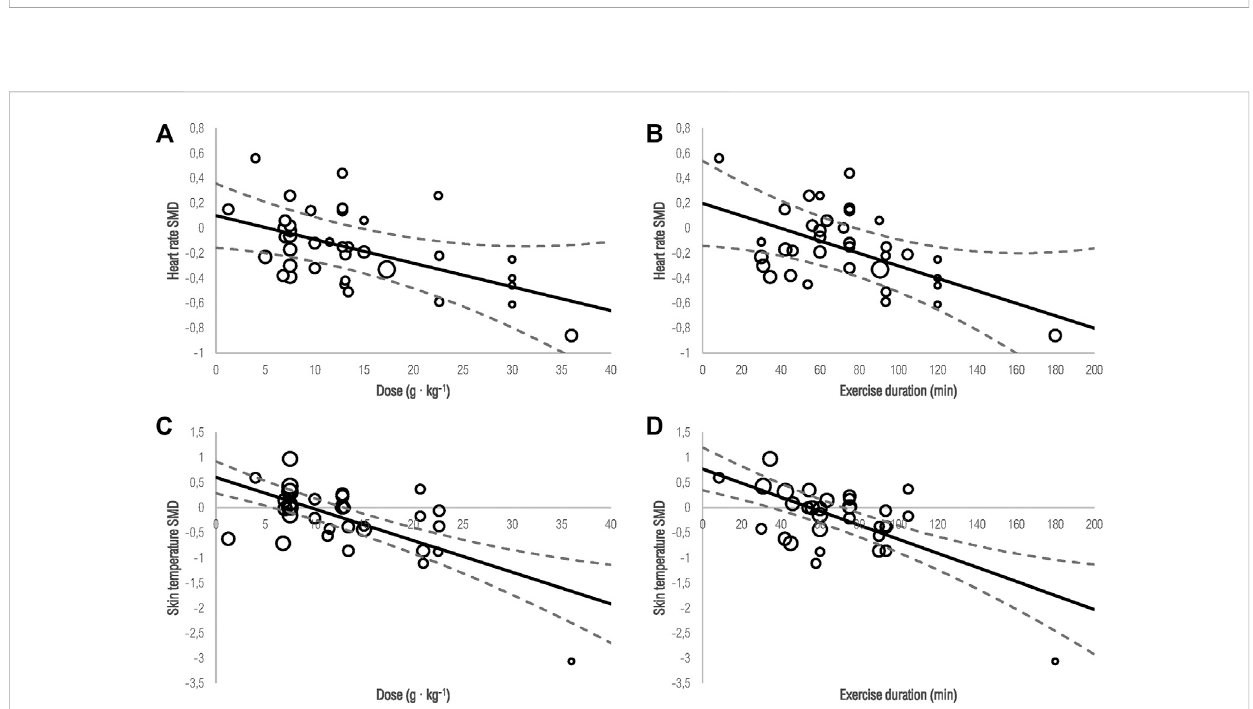
FIGURE 13 Meta-regressionanalysesexploringpotential heterogenityofheartrate asaresultof (A) dose, (B) exercise duration; andskintemperatureasaresult of (C) dose, (D) exercise duration. The bubbles are drawn with sizes proportional to the weight of individual studies. The solid line represents linear predicitions for the effect size while the curved lines represent lower and upper 95%